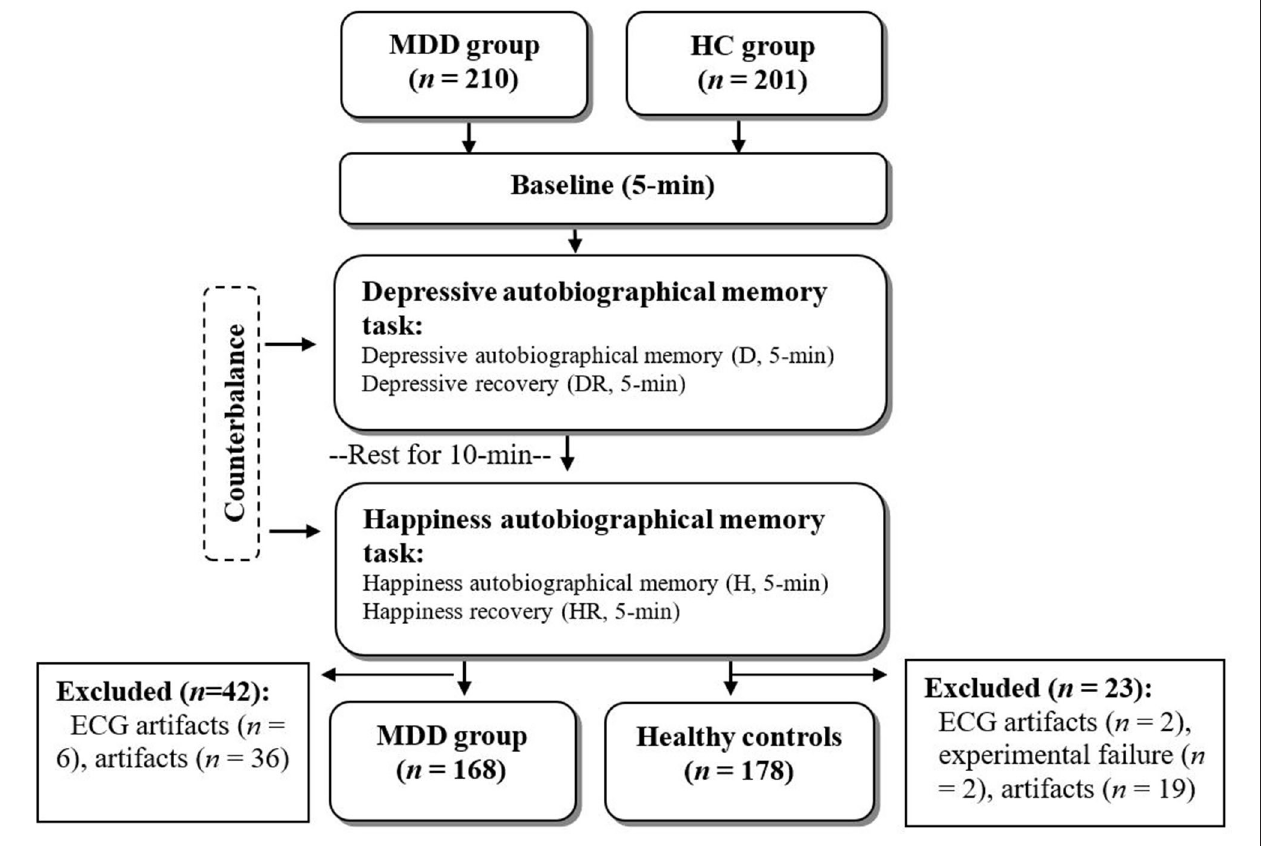
FIGURE 1 | Study flow